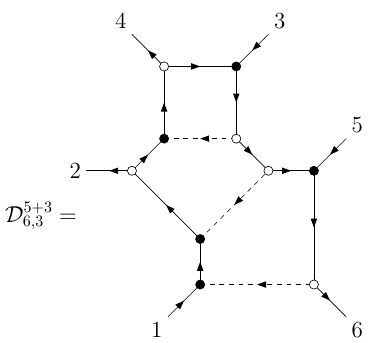
Figure 11 . On-shell diagram combining a 5-point MHV amplitude with a 3-point MHV amplitude. This diagram needs to be summed over the permutations 2 ↔ 4 and 3 ↔ 5